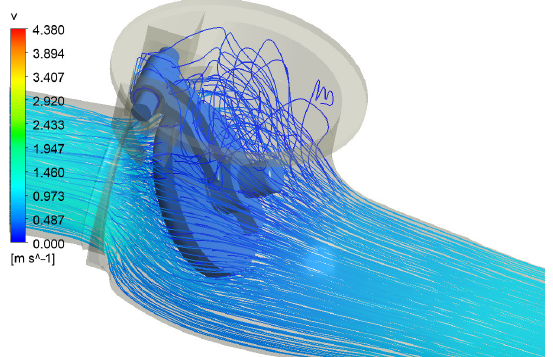
Figure 7. 40% opening internal flow line distribution.